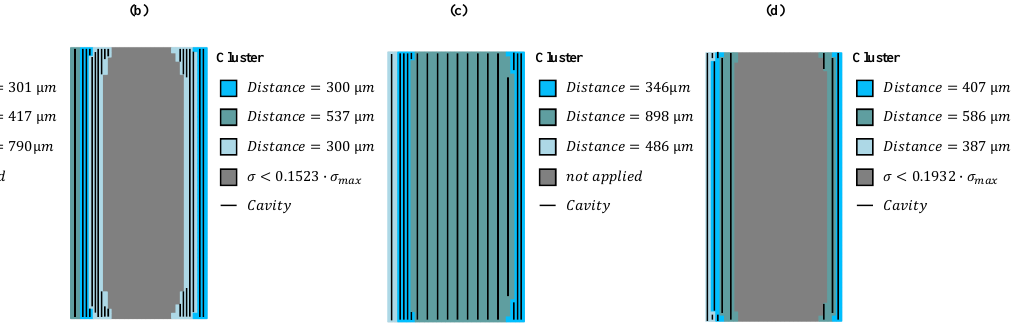
Figure 16. Winning scenarios of the optimization approach for the benchmarks with a distance of 300 µm ( a ), 400 µm ( b ), 500 µm ( c ) and 600 µm ( d ) (see Table 2).